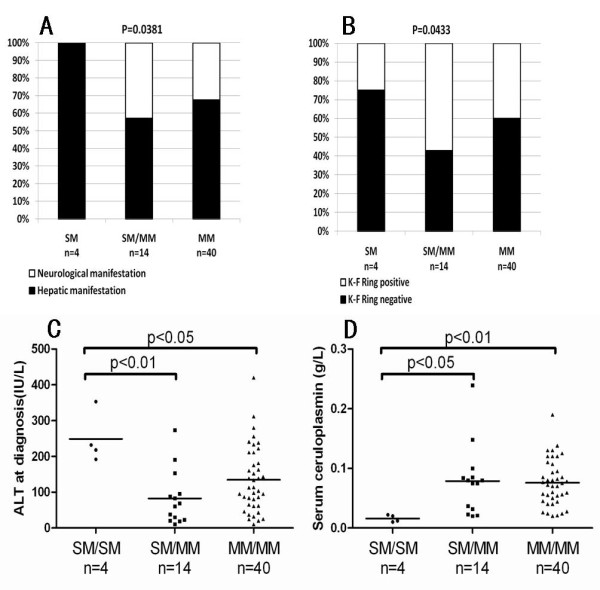
Correlation of severe mutations (SMs) with clinical manifestations (A), corneal Kayser-Fleischer ring (B), ALT levels at diagnosis (C) and serum ceruloplasmin (D). SM, nonsense mutation and frameshift mutations; missense mutations (MM); SM/SM, patients possessing two severe mutations; SM/MM, patients possessing one severe and one missense mutation; MM/MM, patients possessing two missense mutations.